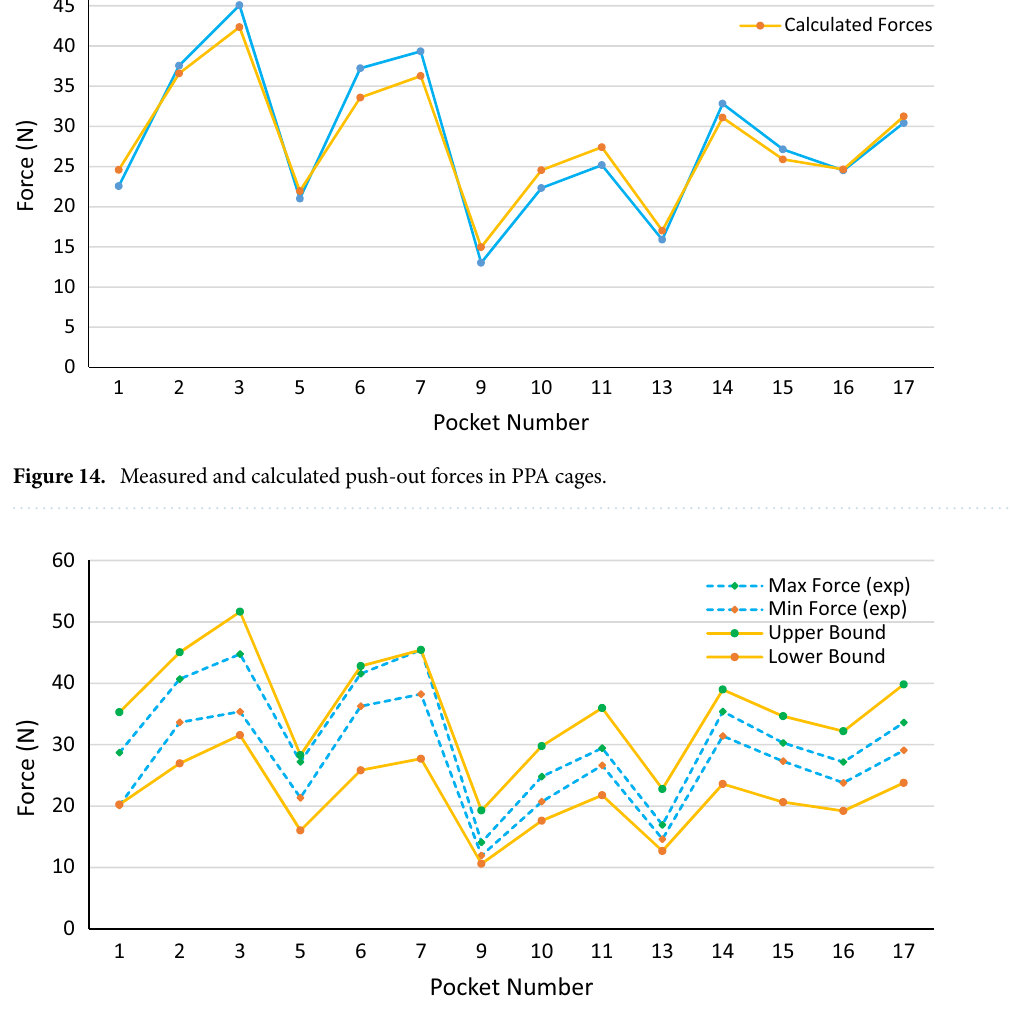
Figure 15. The range of measured push-out forces and calculated upper and lower bonds with six sigma variations in material properties, 0.02 mm in pocket width, and 0.05 mm in other dimensions for PA46